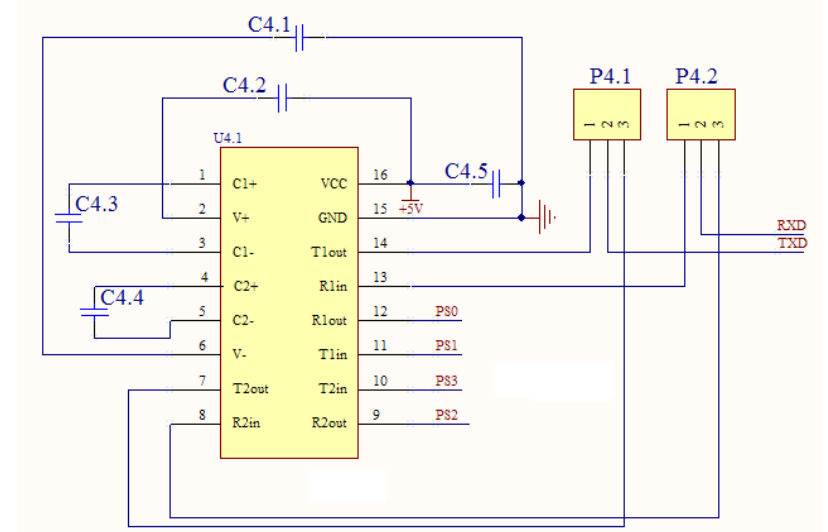
Figure 5. Serial communication circuit.